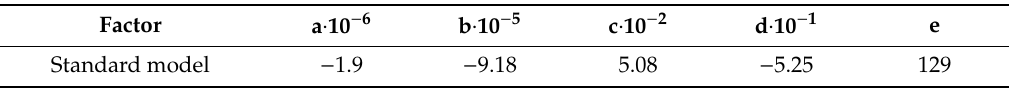
Table 1. Coe ffi cients of the regression models proposed by van Dieen and de Looze for predicting the back extensor muscle moment arm and the orientation of the line of action as a function of the thorax-to-pelvis flexion